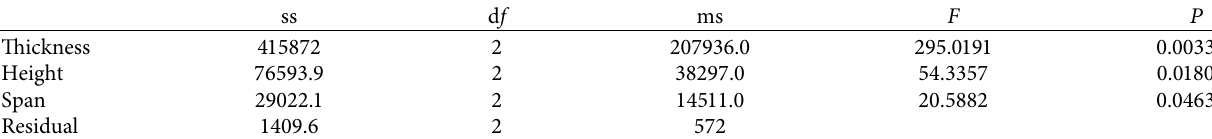
Table 6: Analysis on variance results.